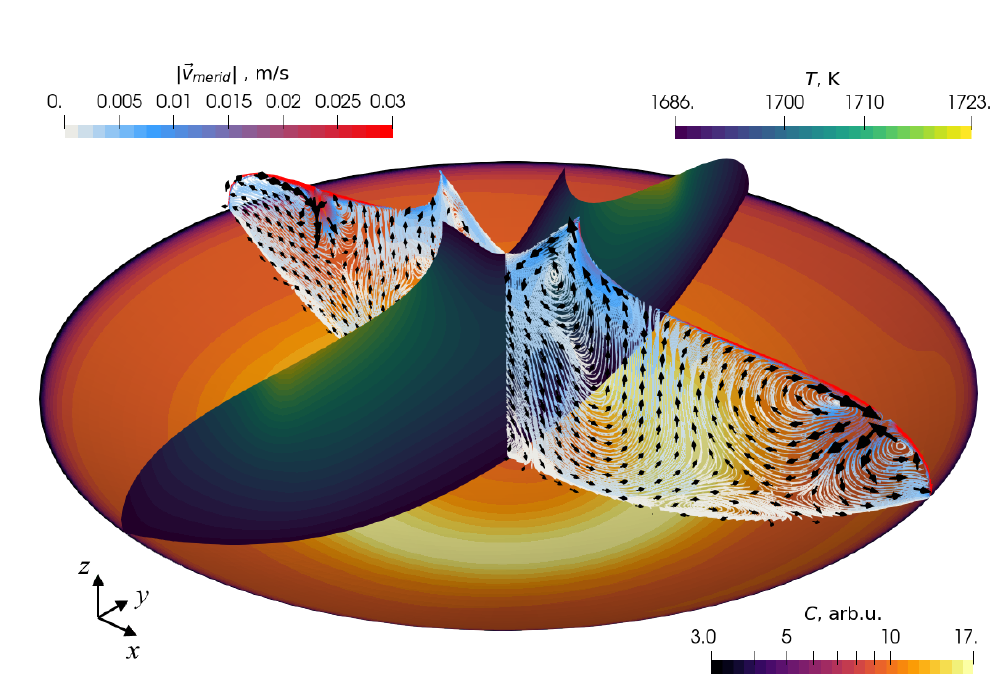
Figure 10. The time-averaged meridional melt velocity in the xz plane, temperature in the yz plane and carbon concentration on the crystallization interface, simulated for the cylindrical phase ( D C = 102 mm). The direction of the main inductor current suppliers corresponds to the x axis. The OpenFOAM simulations can be performed only using a fixed melt shape (stationary phase boundaries). The FZone calculation of the cylindrical growth stage with a diameter of 102 mm was used. In addition, the results from FZoneT with several cone diameters were selected to simulate the melt flow in a cone phase: 80, 60 and 45 mm. The simulated melt velocity in the vertical plane parallel to the main inductor slit is shown in Figure 11, left. Comparison between the EM and Marangoni force densities on the free surface shows that the EM forces dominate; see Figure 12. The EM force is creating an inwards-directed flow at the outer part of the melt. The melt flow is more intensive for the smaller D C due to larger EM field